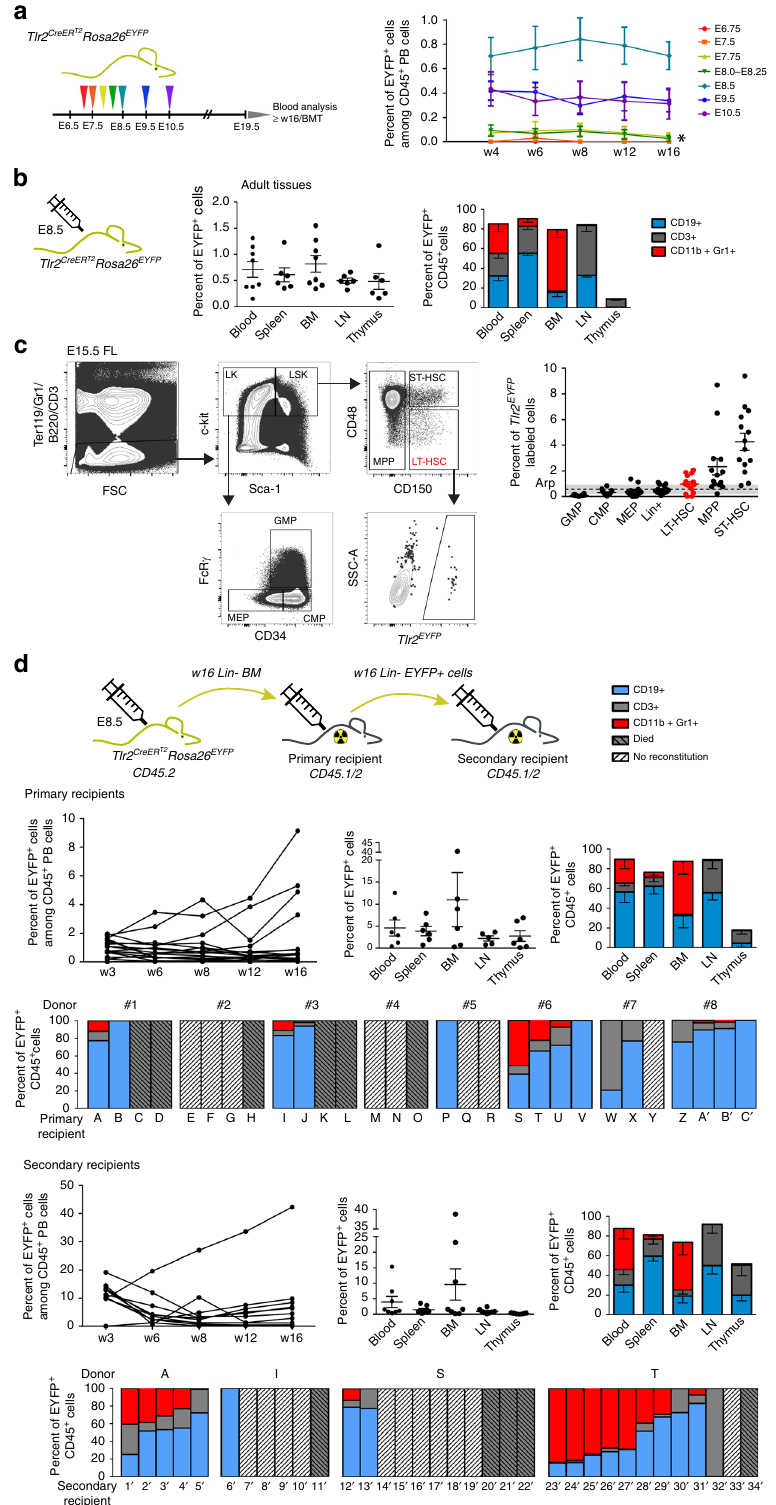
ontogenetically synchronized. The indication that the activation of the in fl ammatory expression program occurs during EHT 32,45 , together with our fi nding that TLR2 stimulation of the earliest TLR2 + c-kit + YS precursors as well as BM-derived HSCs 29 aug- mented their myeloid fate, suggests that the mechanism of TLR- driven hematopoiesis under in fl ammatory conditions is not